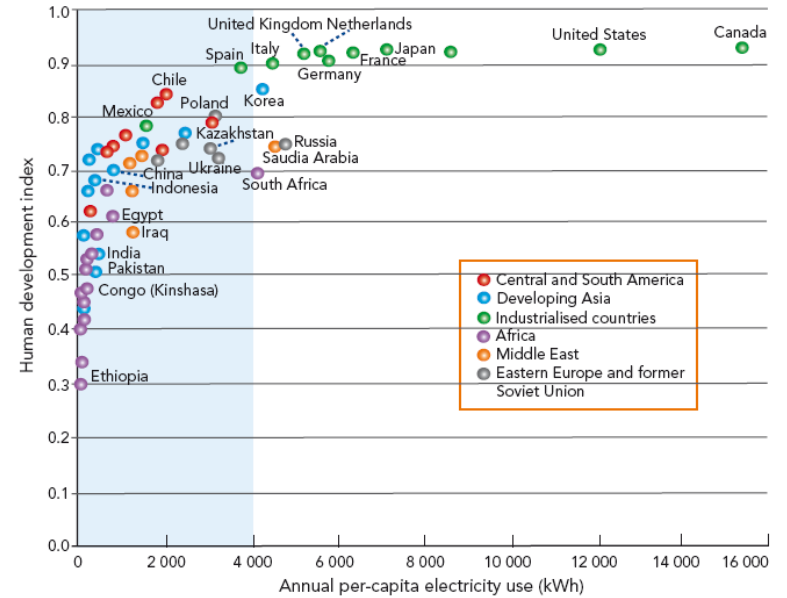
Figure 4. Per-capita electricity consumption and Human Development Index (after [62]). © 2008 OECD, reproduced from [61] with permission.